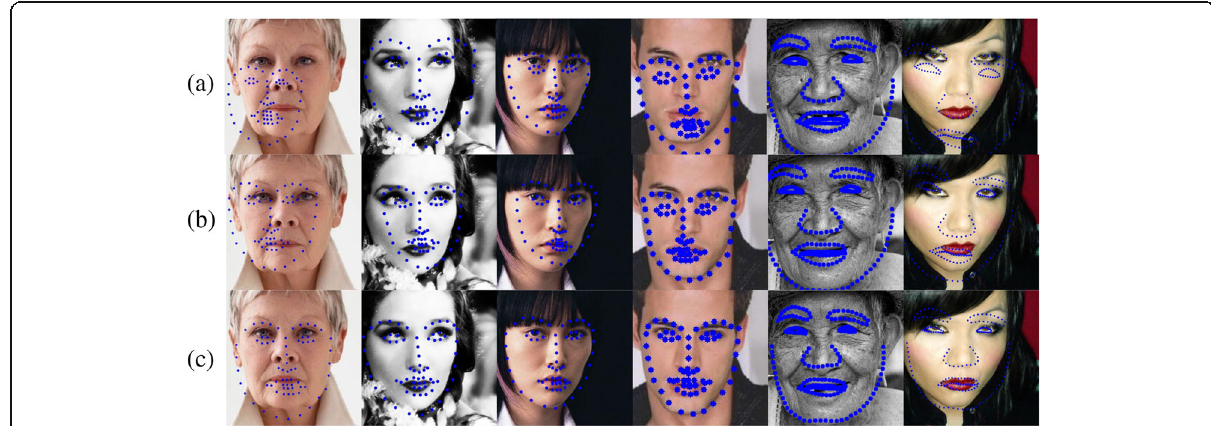
Fig. 13 Selected face alignment results by using a the ESR method (top row), b the MSR method with pixel and region difference features (bottom row), and c the MSR with pixel, region, and gradient difference features (final row)